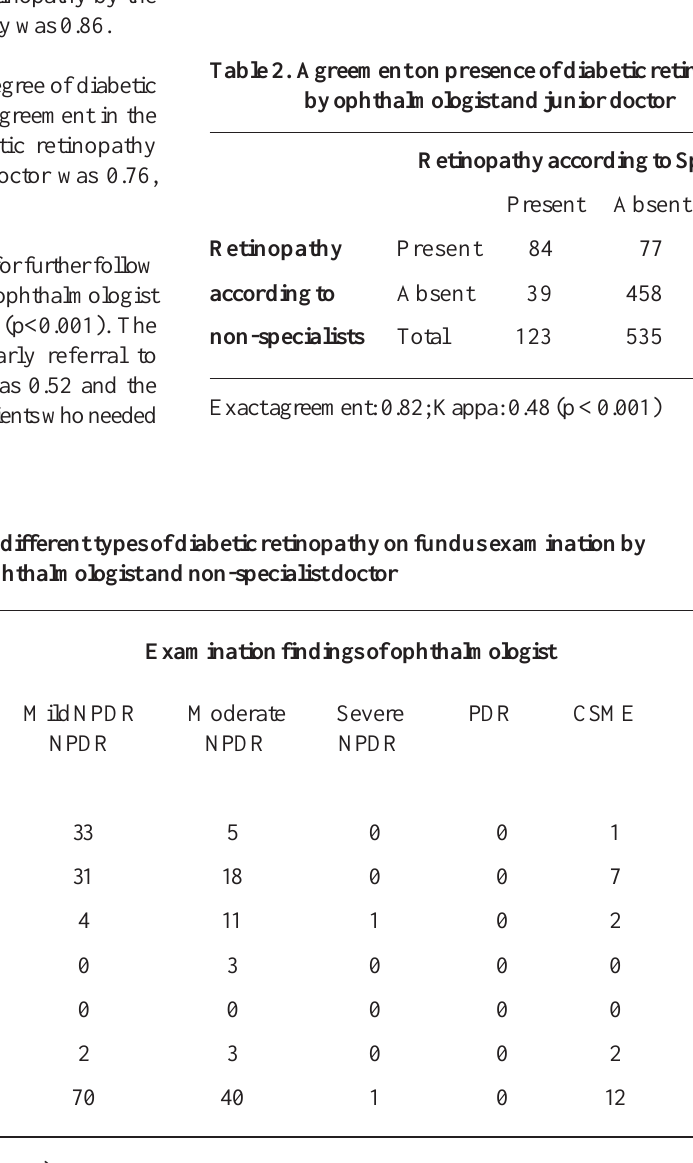
Table 2. Agreement on presence of diabetic